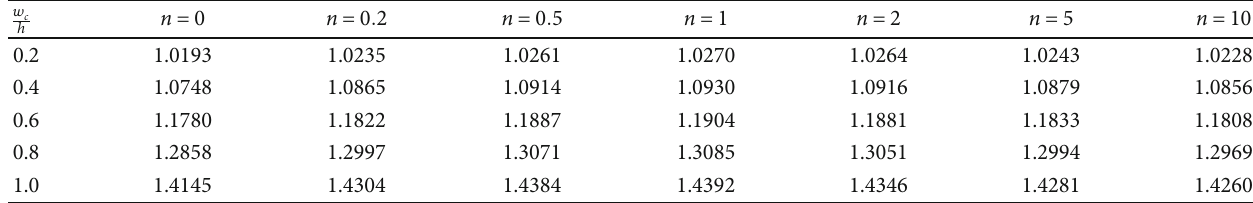
ω NL / L of 2D-FGM square plate,